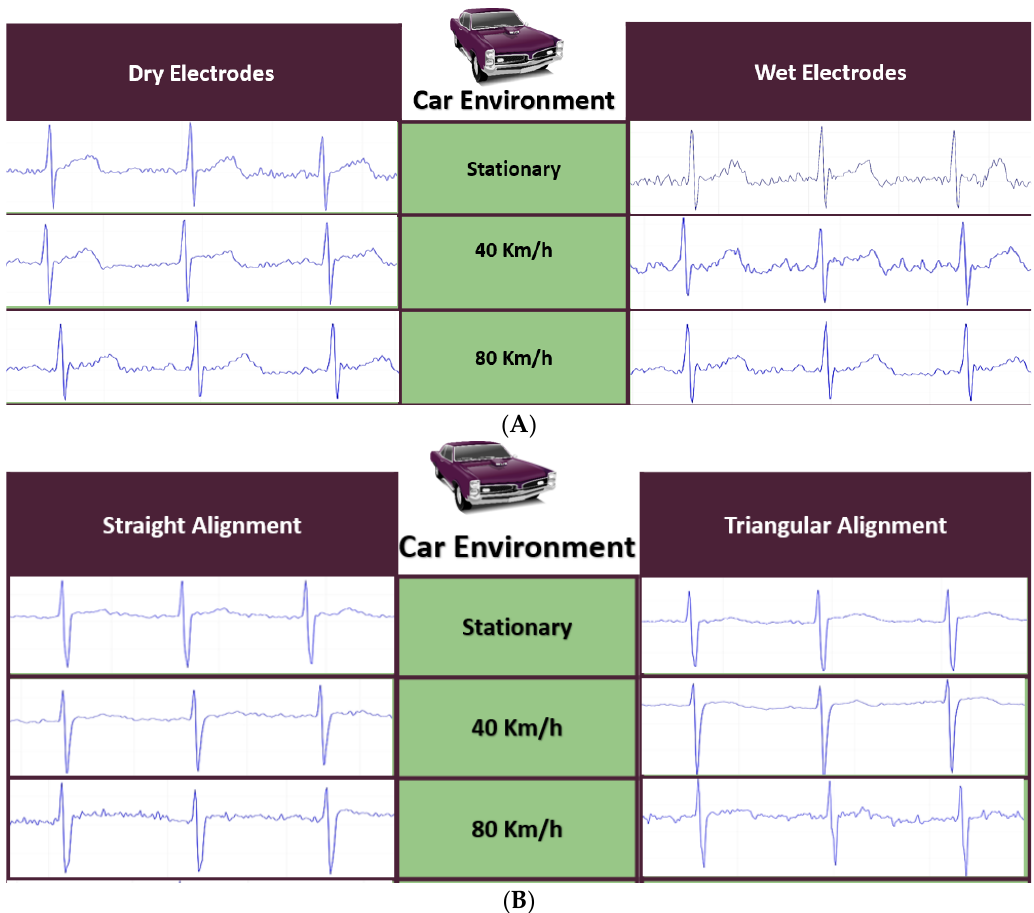
Figure 11. Performance of dry electrodes in comparison to wet electrodes ( A ) and different lead configurations ( B ) at different vehicle speeds.